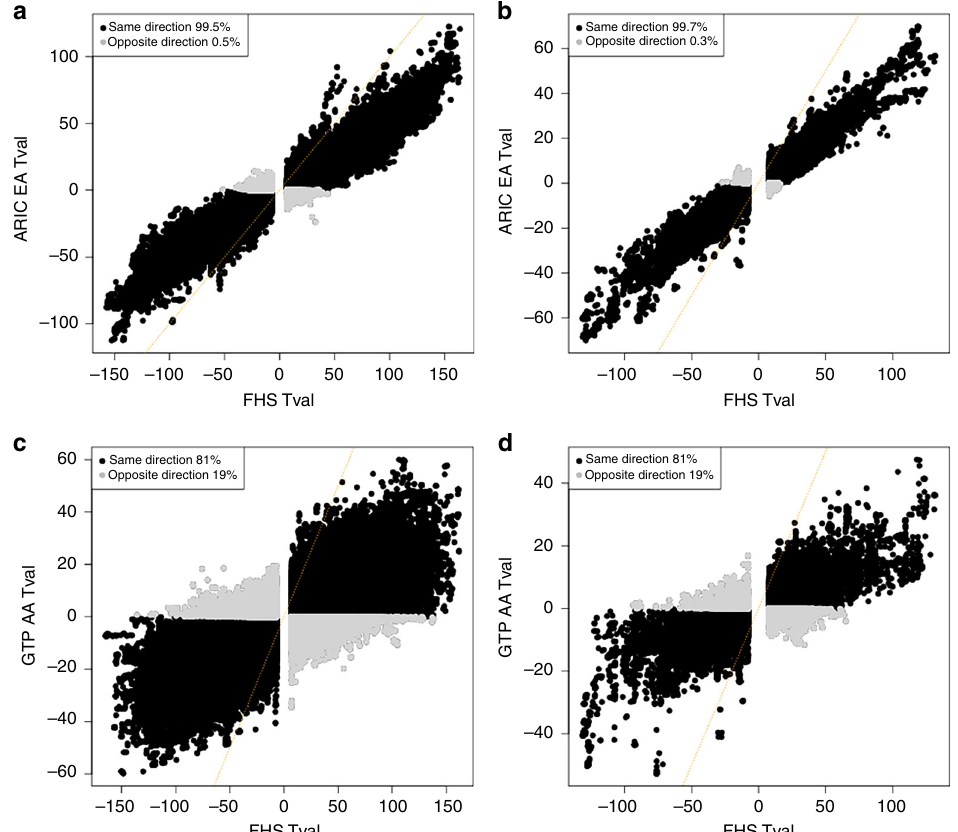
Fig. 2 Plot estimates of cis- and trans- meQTLs in independent studies. a T-values of cis- meQTLs identi fi ed in FHS vs ARIC EA; b T-values of trans- meQTLs identi fi ed in FHS vs. ARIC EA; c T-values of cis- meQTLs identi fi ed in FHS vs GTP AA; d T-values of trans- meQTLs identi fi ed in FHS vs. GTP